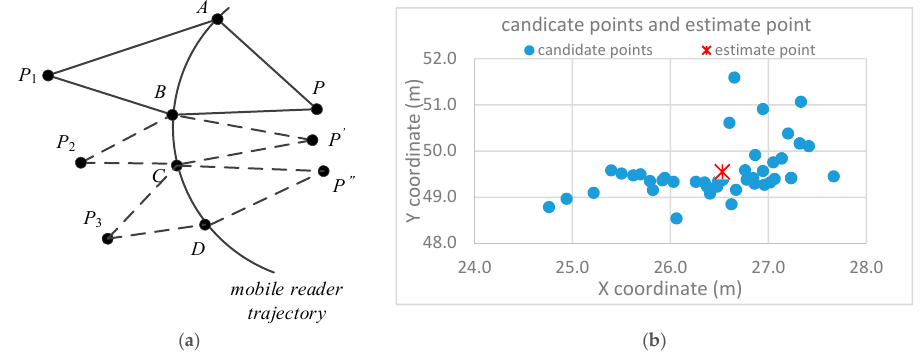
Figure 3. Proposed location algorithm. ( a ) One triangle composed of three points, practical model of triangulation. Where, A, B, C, D are RFID reader position; P, P’, P” are candidate target tag location; the arc represents the mobile reader trajectory. ( b ) Candidate points and estimated point.